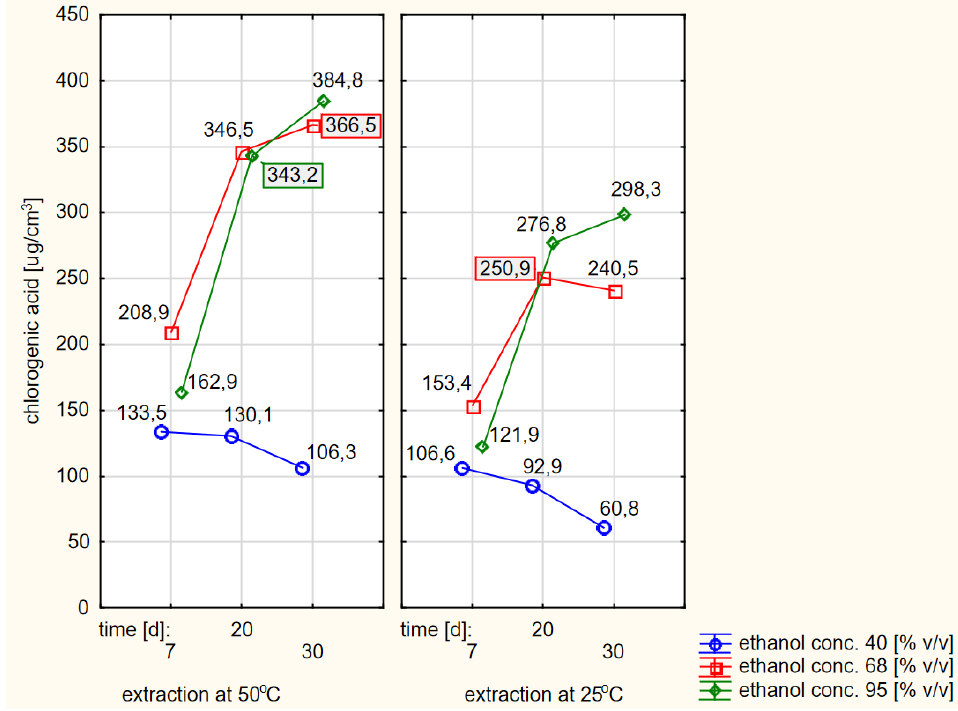
Figure 7. Profiles of chlorogenic acid values in ethanol extracts for the dried raw material obtained from fresh elderberry flowers, presented separately for the hot and cold extraction variants.